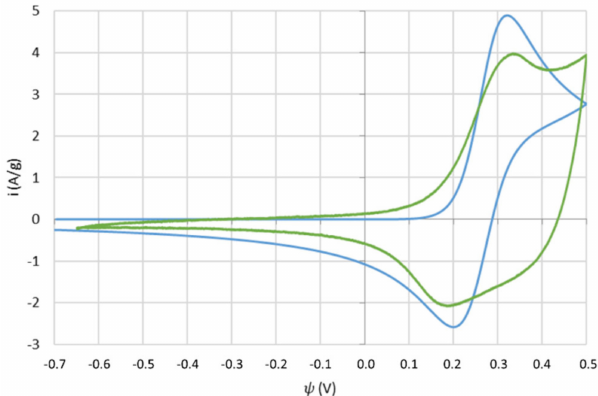
Figure 8. Simulated and experimental CV curves of the cobalt hydroxide nanofoam